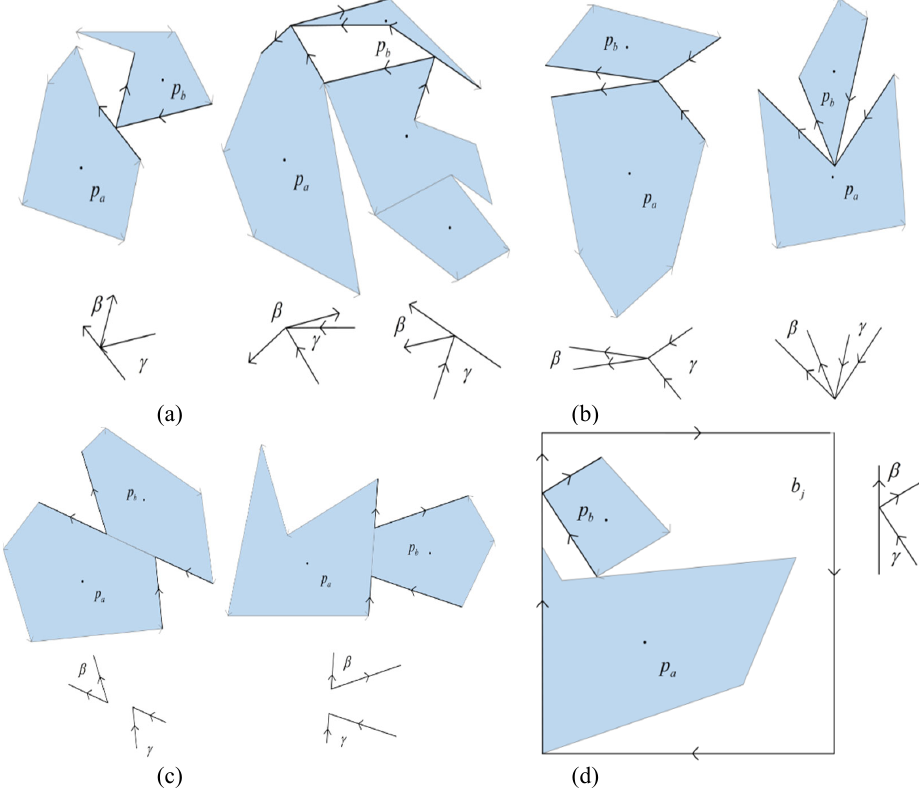
Fig. 4. (a) An edge-vertex combination, (b) A vertex-vertex combination, (c) An edge-edge combination, (d) Angles generated by the bin’s